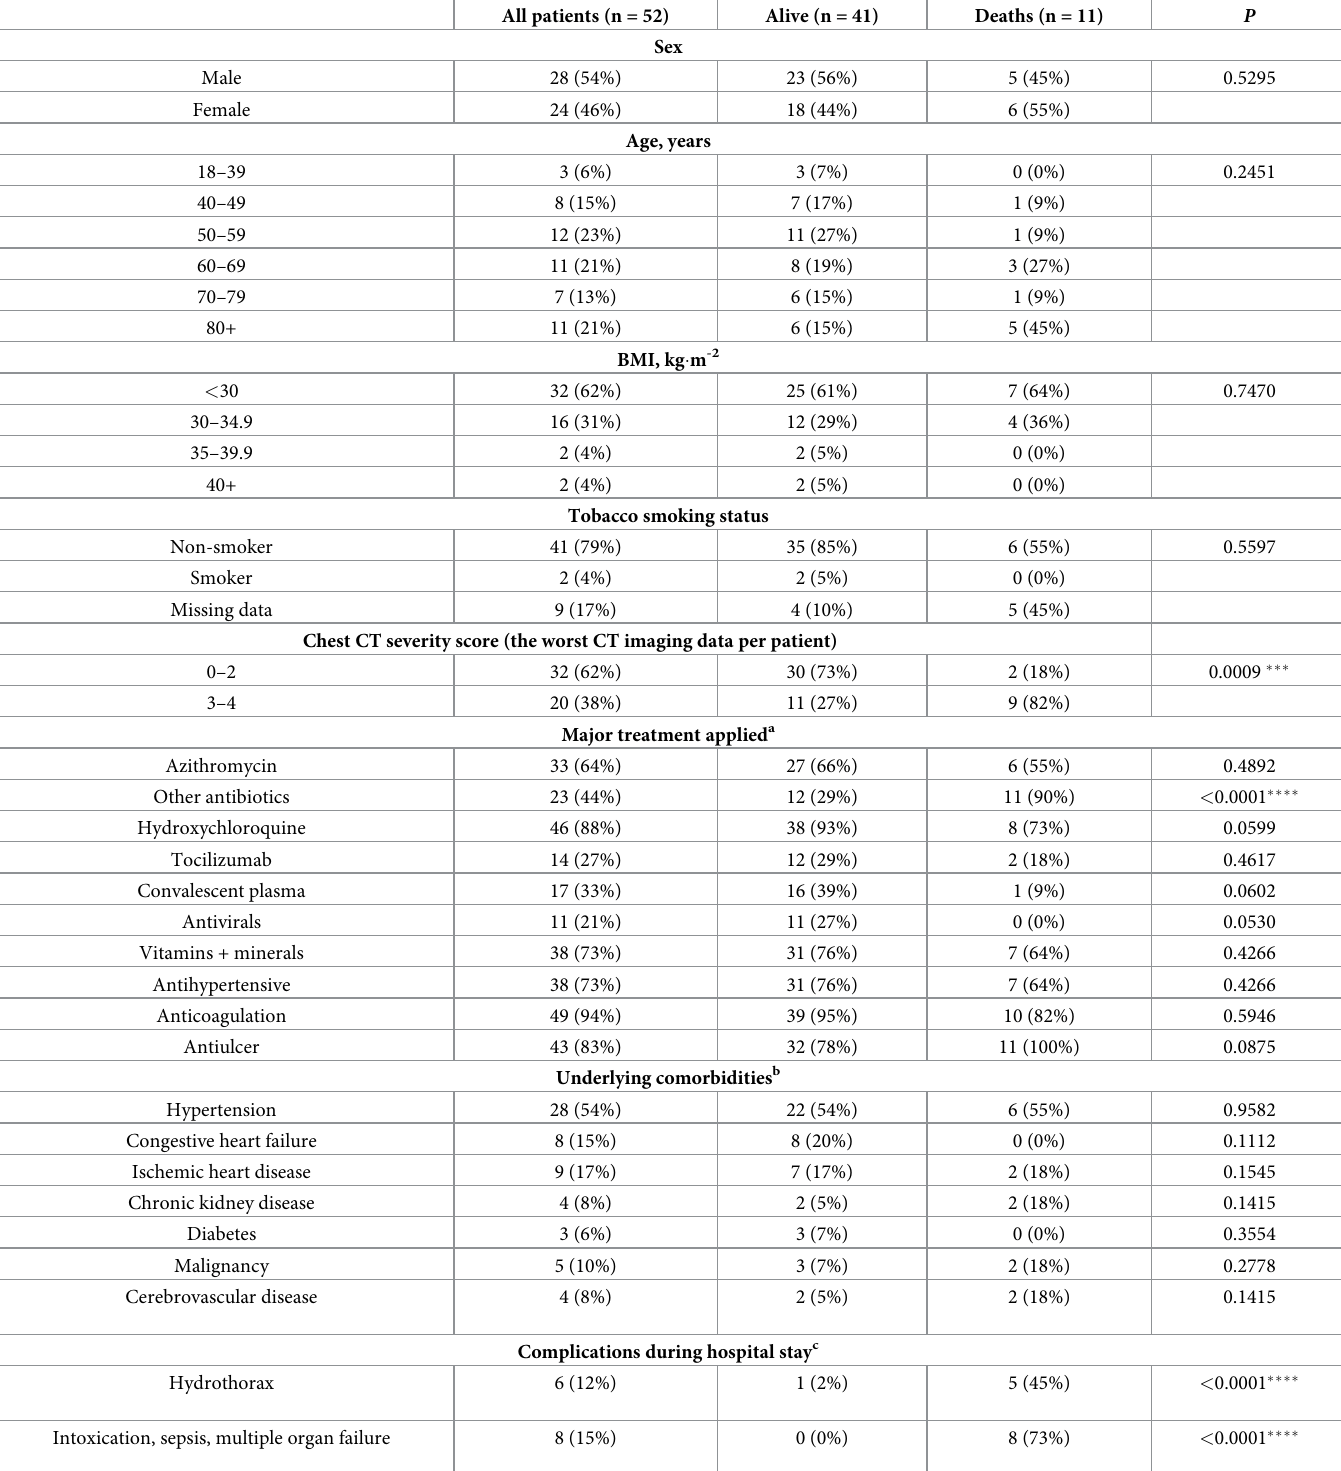
Table 1. Cohort description with COVID-19 deaths by patient